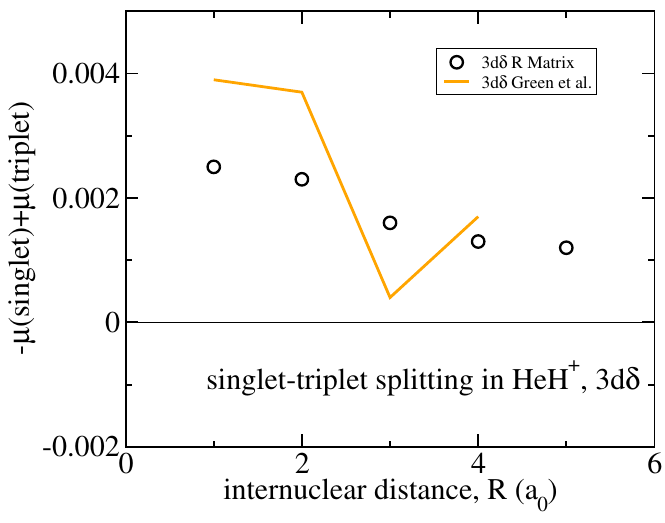
Figure 4. Singlet-triplet splitting in the 3˜ d (cid:5) state of HeH + . The quantity plotted is ν (singlet)- ν (triplet) ≡ − (cid:4) (singlet)+ (cid:4) (triplet) as a function of R . The meaning of the symbols is indicated in the figure.